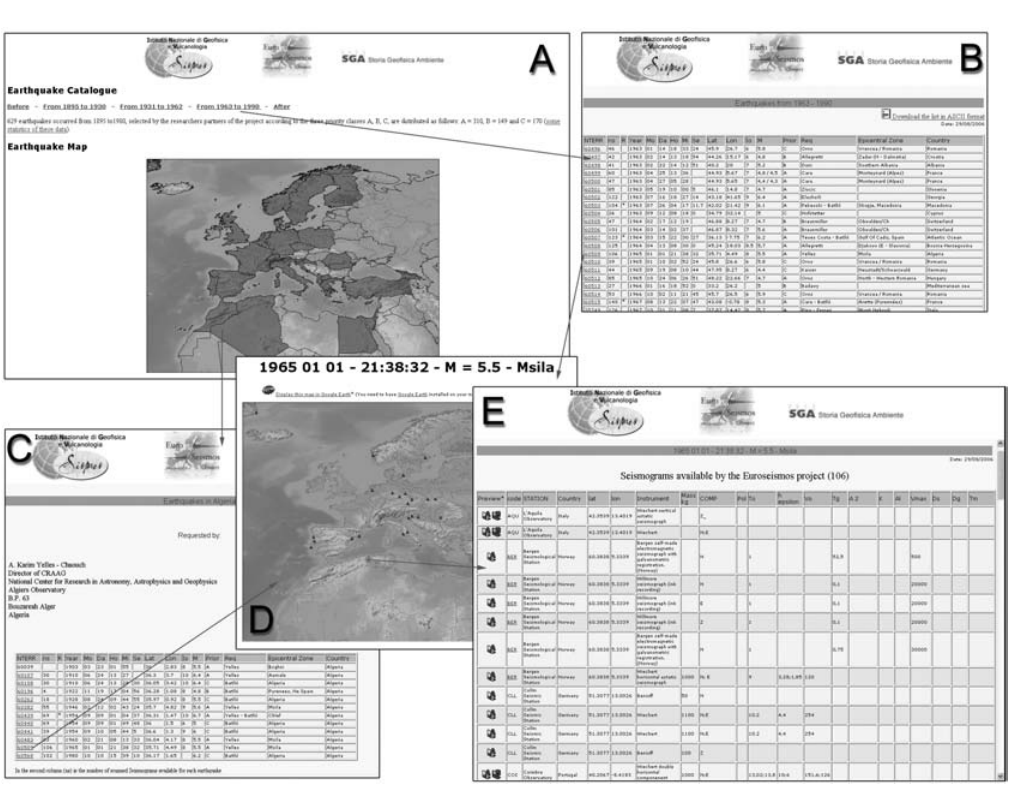
Fig. 14. From the «Main and regional list» section of the ES Website (A), it is possible to access the consulta- tion of the data available for each of the 611 earthquakes chosen by the project partners, both on chronological (Earthquake Catalogue) (B), and geographical grounds (Earthquake Map) (C), in relation to the country in which the epicentres are localised. From both windows it is possible to select the earthquake of interest and visualise an interactive map all the stations where seismograms scans are available in the SISMOS database, besides the epicentre of the event (D). By clicking on one of the sensitive points the list of seismograms available in the SIS- MOS database for that earthquake is visualised; for each one the main data present in the TROMOS database re- lating to the observatory and the recording instrument and its constants (E) are reported. By clicking on the icon of the left-hand column of the latter window (E) it is also possible to access a low-resolution preview of the seis-